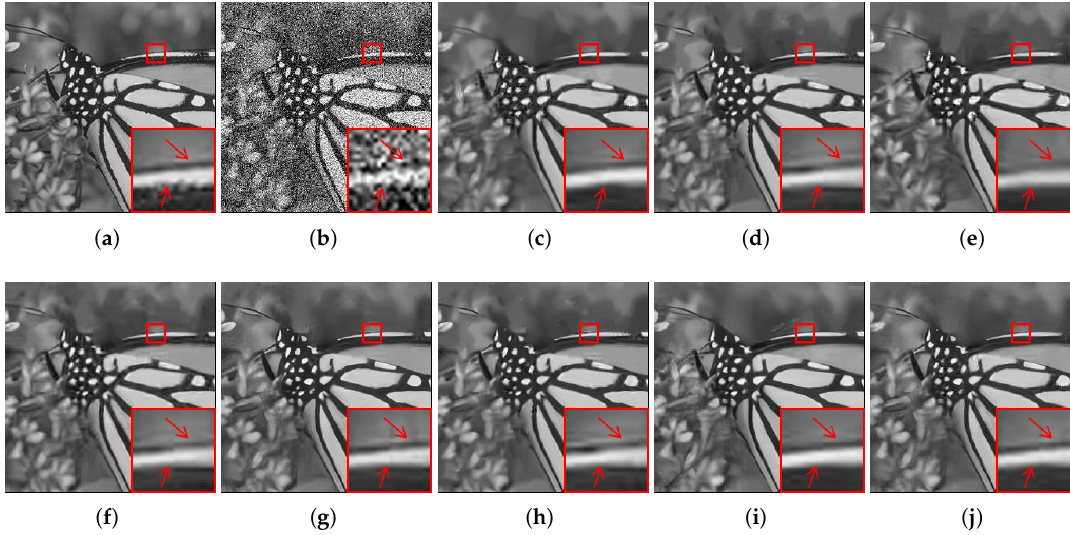
Figure 7. Comparison of denoising results of the competing methods for image Monarch with noise level σ = 50. ( a ) Original image. ( b ) Noisy image. ( c ) NCSR, PSNR = 25.69 dB. ( d ) WNNM, PSNR = 26.22 dB. ( e ) PGPD, PSNR = 25.97 dB. ( f ) BM3D, PSNR = 25.64 dB. ( g ) DnCNN, PSNR = 26.65 dB. ( h ) TWSC, PSNR = 26.16 dB. ( i ) FFDNet, PSNR = 26.65 dB. ( j ) Proposed, PSNR = 26.77